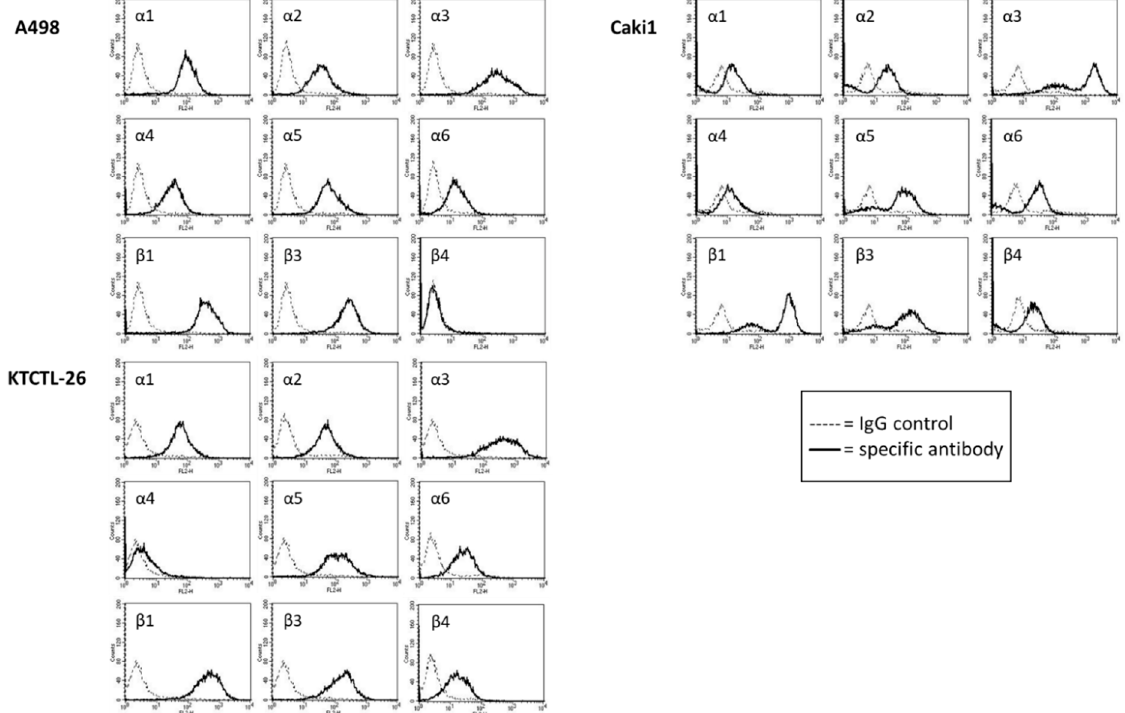
Figure 5. Surface expression of α and β integrins on A498, Caki1, and KTCTL-26 cells. Measured by Figure 1. PE, IgG2a-PE and IgG2b-PE (dashed line). The abscissa shows the relative logarithmic distribution of the relative fluorescence intensity of α 1- α 6 and β 1, β 3, and β 4. The ordinate shows cell number. 10,000 cells were counted. Figure is representative for n = 6.